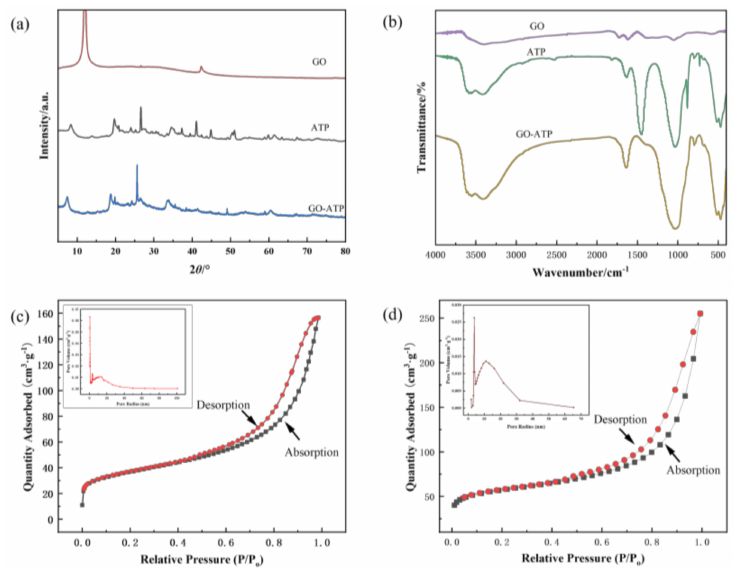
Figure 3. ( a ) XRD patterns of GO, ATP and GO − ATP samples; ( b ) FT − IR spectra of GO, ATP and GO − ATP composites; nitrogen adsorption and desorption isotherms and pore size distribution of ATP ( c ) and GO − ATP ( d ) specific surface area of ATP.